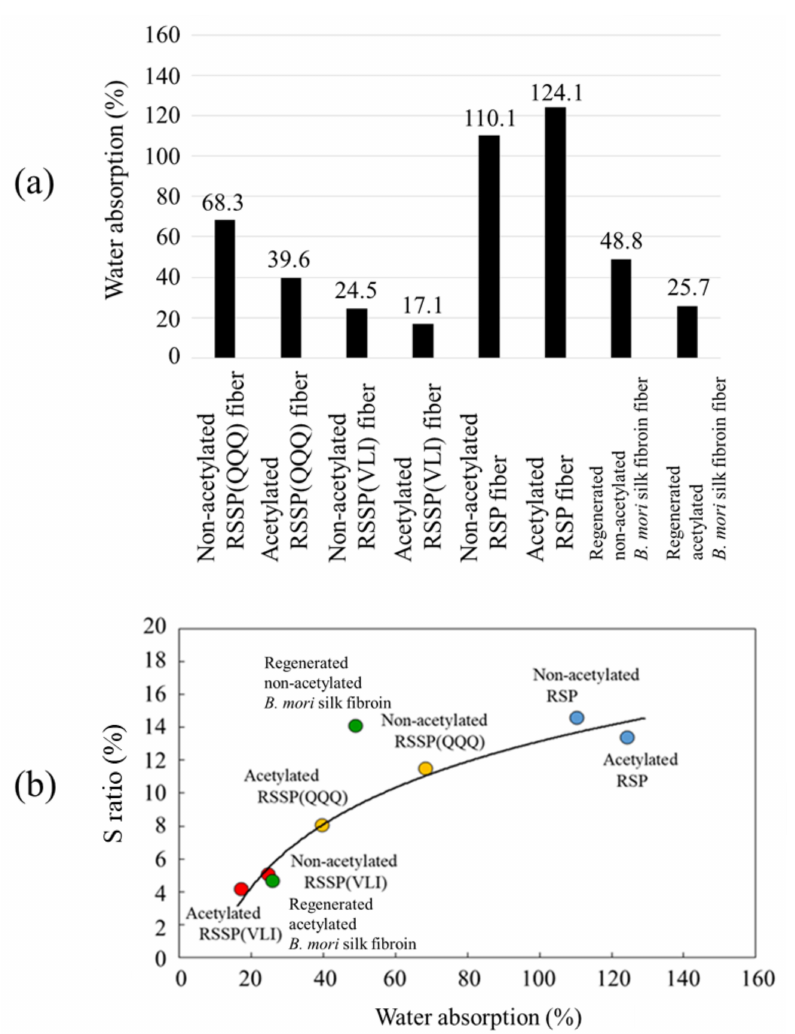
Figure 8. ( a ) The water absorption (%) and ( b ) the correlation between the water absorption (%) and the S ratio (%) observed for eight kinds of silk fibers, i.e., non‑acetylated and acetylated fibers of RSSP(QQQ), RSSP(VLI), RSP, and regenerated B. mori silk. Water absorption and S ratio are defined in the text. The data of both non‑acetylated and acetylated fibers of RSSP(QQQ), RSSP(VLI), RSP, and regenerated B. mori silk are the circles colored in orange, red, blue, and